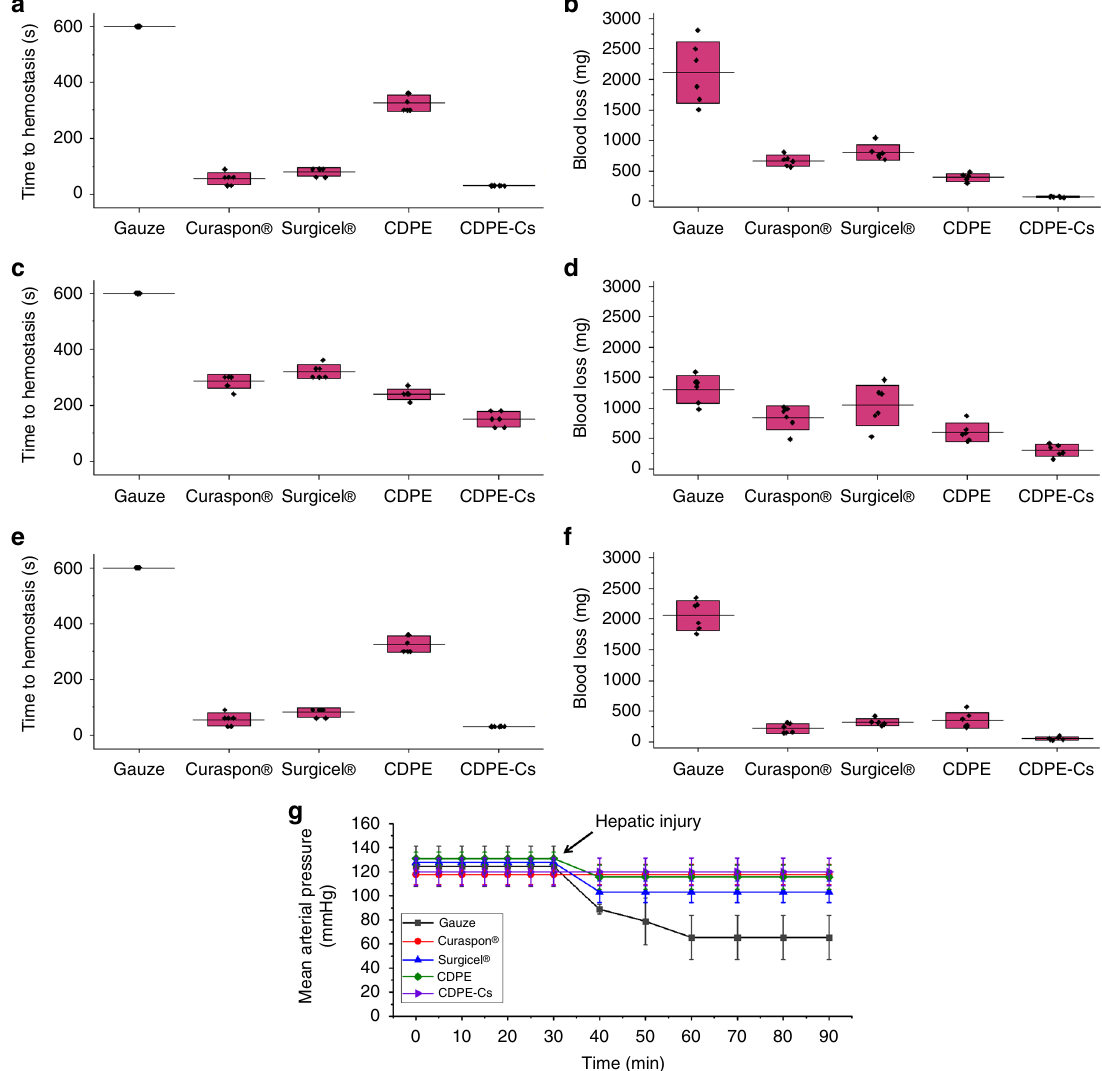
Fig. 3 In vivo examination of CDPE-Cs hydrogels against several controls. a Conventional gauze dressings, Curaspon ® , Surgicel ® , and CDPE and CDPE-Cs hydrogels were applied immediately after induction of the liver injury and absorption of the initial bleeding from the injury sites, to determine the total time to hemostasis in rats ( n = 6 animals per group). For gauze dressings, bleeding did not stop until the end of experiments (600 s). b The total amount of blood loss, measured over 10 min, in rats ( n = 6 animals per group). c Time to hemostasis for rabbits ( n = 6 animals per group). d Blood loss in rabbits ( n = 6 animals per group). e Time to hemostasis for pigs ( n = 6 animals per group). f Blood loss in pigs ( n = 6 animals per group). g The mean arterial pressure of the rabbits were monitored over 90 min, where the measurements over the fi rst 30 min represent the mean arterial pressure of animals before induction of the liver injury ( n = 3 animals per group). Box plots correspond to means (center line) ± SD (boundaries). Source data are provided as a